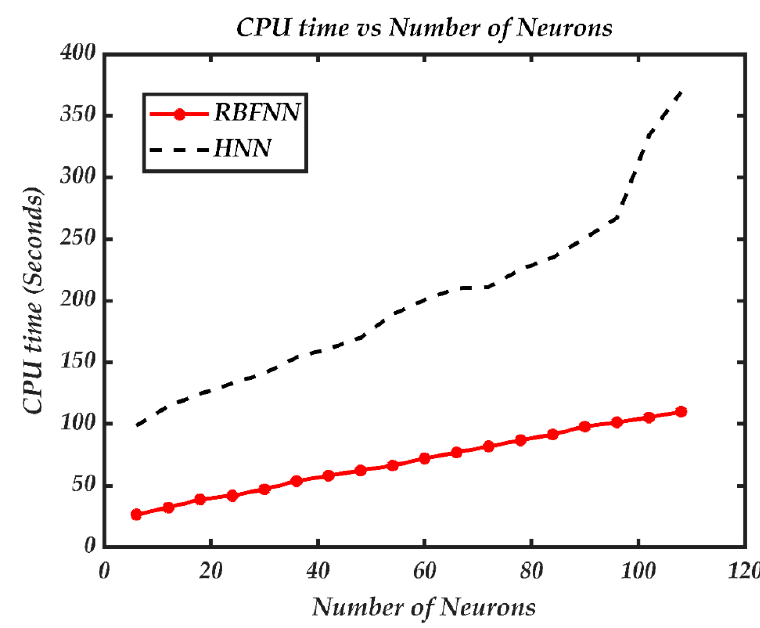
Figure 6. The performance of proposed RBFNN and HNN in term of CPU time.